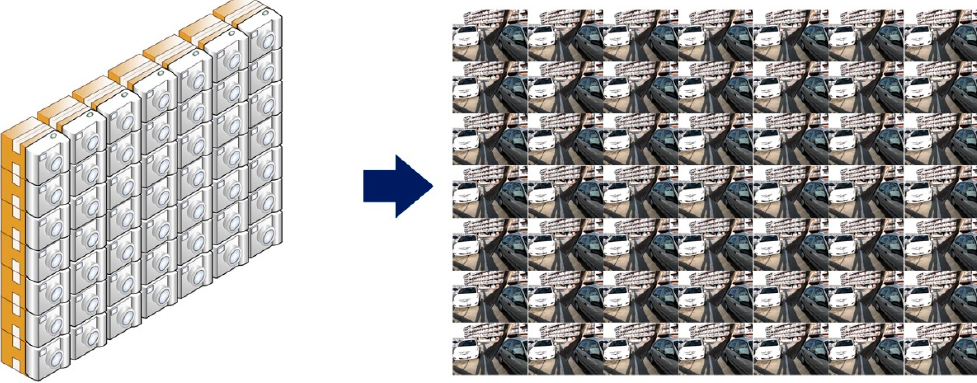
Figure 1. LF imaging captures arrays of light from all directions separately, unlike conventional imaging, which captures intensity from only one direction. This can be imagined as a group of cameras taking pictures of the same scene at the same moment. These cameras are arranged as shown and placed very close to each other so that adjacent images differ slightly from each other. This massive data capture opens completely new possibilities. For example, specific parts of the image can be changed to be blurry or in focus, 3D images can be created from only one exposure, and even the depth of field can be changed.